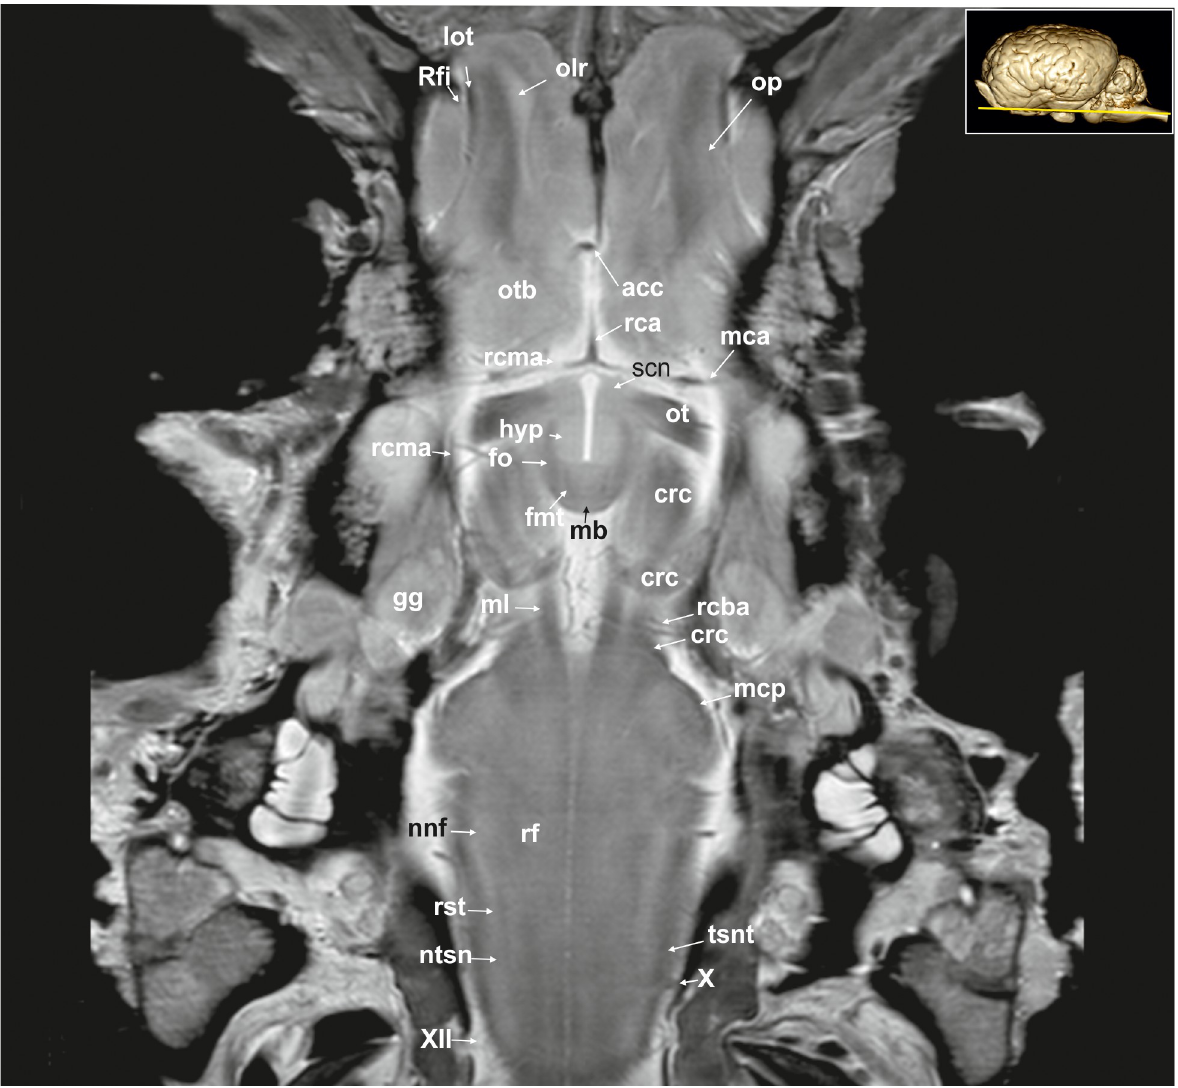
Fig 18. Dorsal magnetic resonance image of the equine brain on the level of the mamillary body. acc: corpus callosum artery, crc: cerebral crus, fmt: mammilo-thalamic fasciculus, fo: fornix, gg: Gasserian ganglion, hyp: hypothalamus, lot: lateral olfactory tract, mb: mamillary body, mca: medial cerebral artery, mcp: medial cerebellar peduncle, ml: medial lemniscus, nnf: nucleus of the facial nerve, ntsn: nucleus of the spinal tract of the trigeminal nerve, olr: olfactory recess, op: olfactory peduncle, ot: optic tract, otb: olfactory tubercle, rca: rostral cerebral artery, rcba: rostral cerebellar artery, rcma: rostral communicating artery, rf: reticular formation, Rfi: rhinal fissure, rst: rubrospinal tract, scn: supracommissural nucleus hypothalami, tsnt: spinal tract of the trigeminal nerve, X: vagus nerve, XII: hypoglossal nerve. White matter. White matter forms the bulk of the deep parts of the cerebral hemispheres, (corpus medullare of the forebrain). Fibers coming from the cerebral convolutions converge in the dorsal hemisphere to a great mass of white matter. Dorsal to the lateral ventricles and cor- pus callosum, it forms the semioval centre (Centrum semiovale; Figs 3–6; S2–S5 Figs: cso). Further ventrally the white matter mass does not contain association fibers running from one part of the hemisphere to the other, but only ascending and descending fibers, together referred to as the corona radiata, give rise to the internal capsule. Seen from the dorsal view on the level of the striatum, the curved, fan-shaped internal capsule can be separated into a rostral